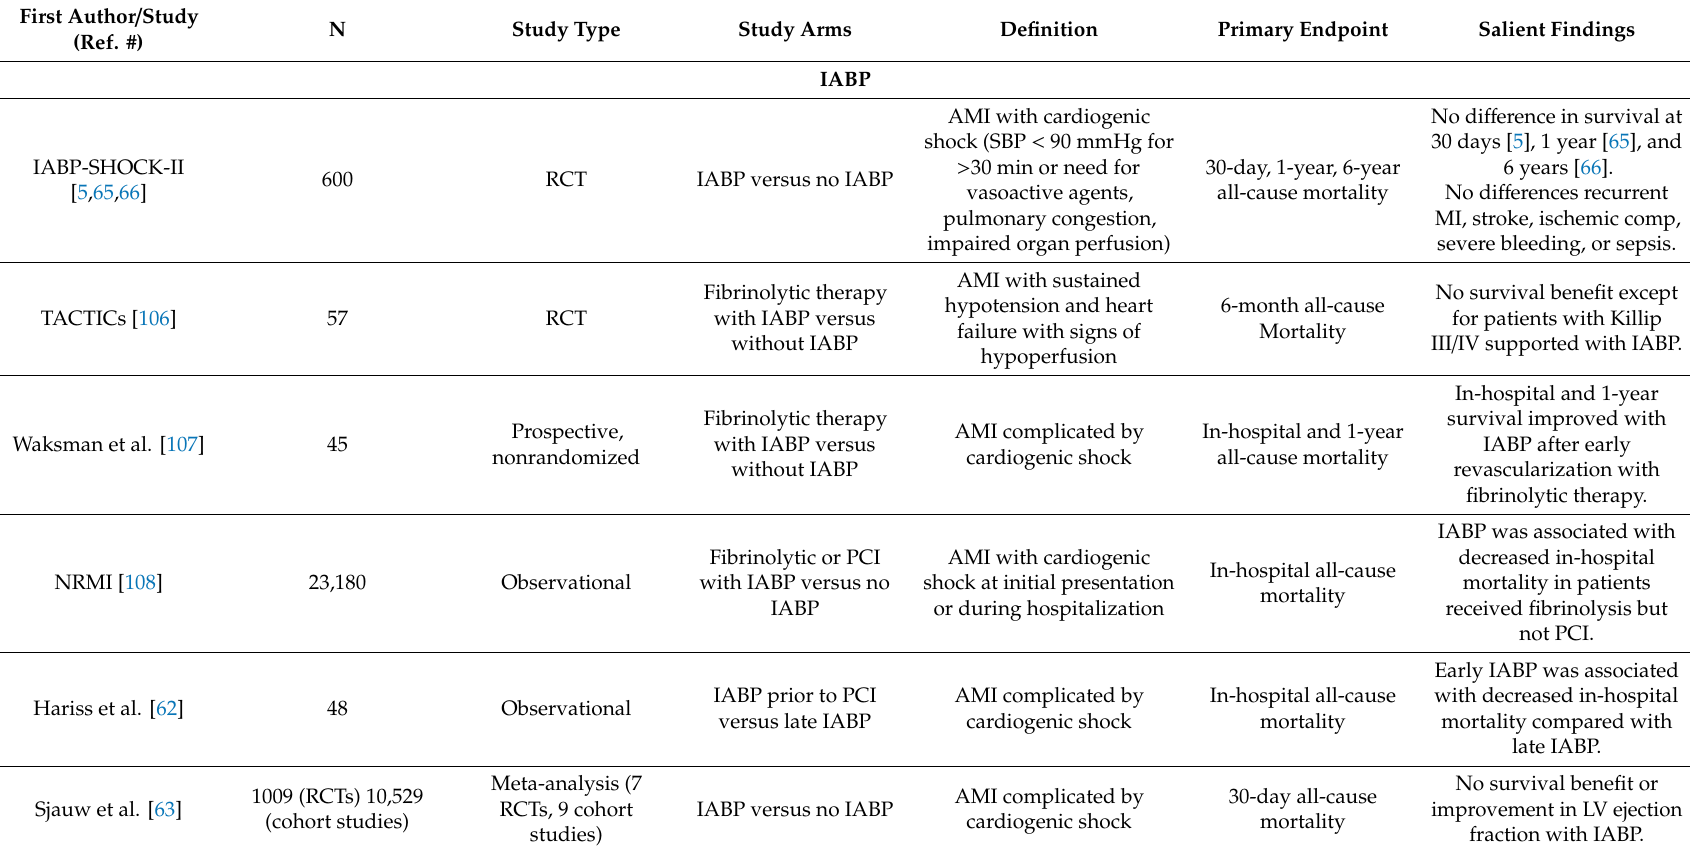
Table 3. Main Clinical Studies of Percutaneous MCS devices in AMI with Cardiogenic